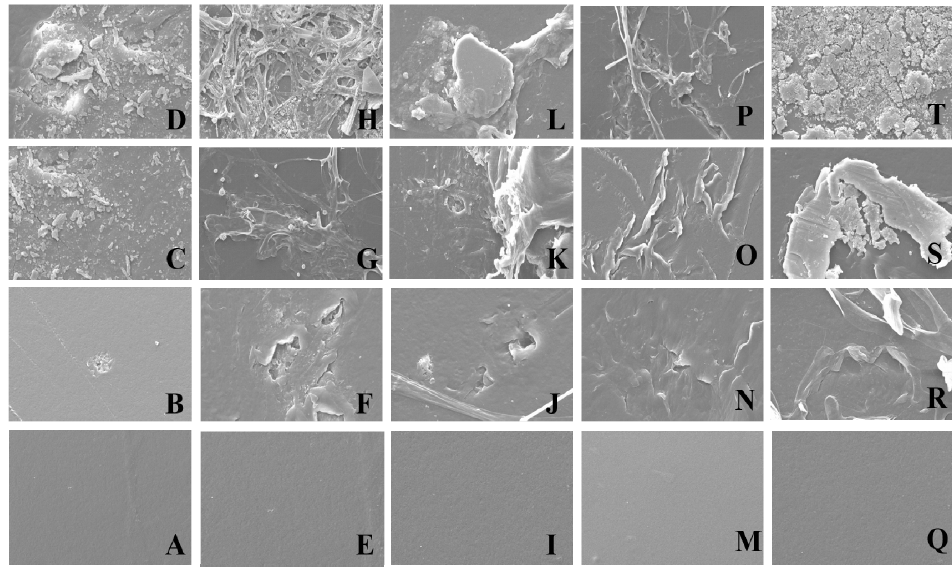
Figure 8. Scan electron micrographs of LDPE films (1000×) cultured with D. italiana ( A – D ), C. fructicola ( E – H ), T. jaczewskii ( I – L ), S. citrulli ( M – P ), and A. niger ( Q – T ) after 0, 30, 60, and 90 days of incubation, respectively.